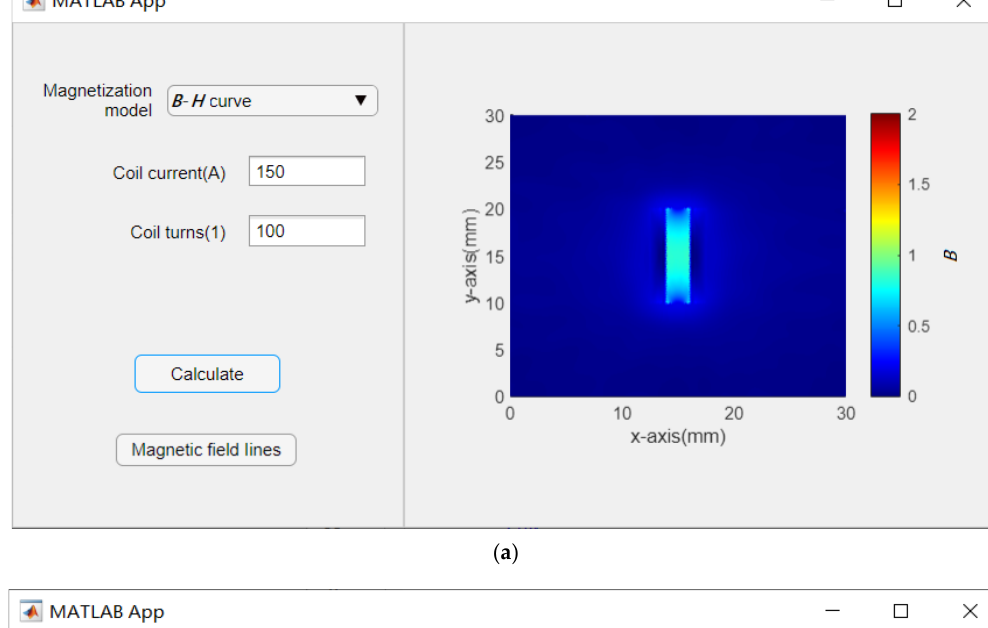
Figure 13. Comparison of magnetic flux density calculations for linear materials.